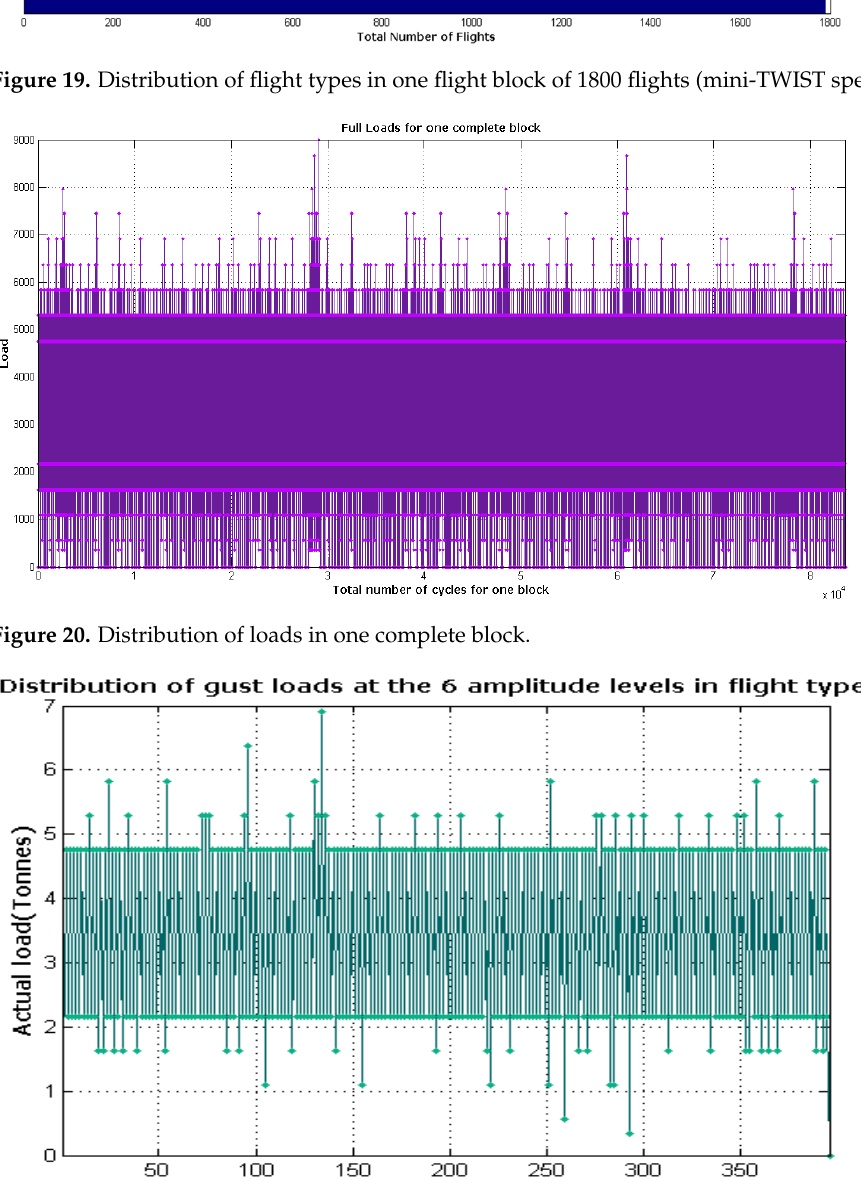
Figure 21. Distribution of loads in flight type E.